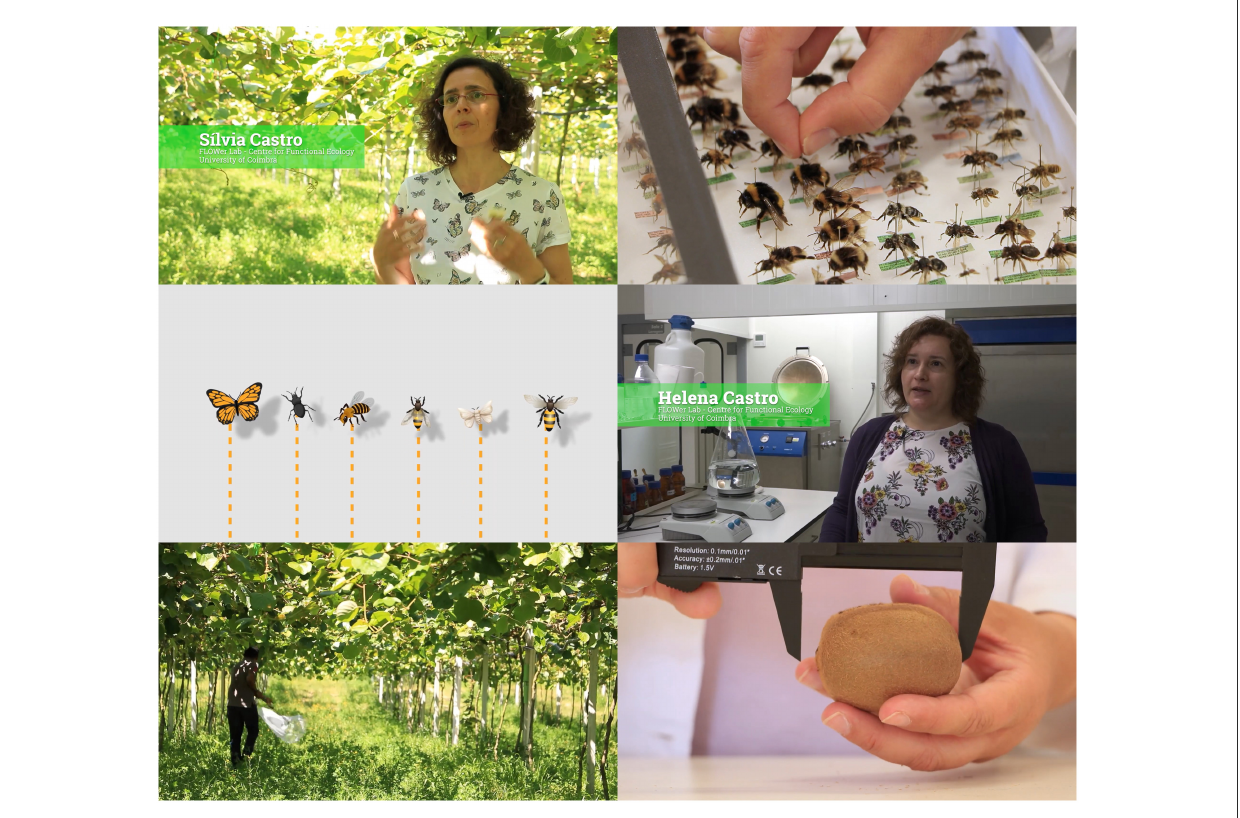
FIGURE1 Screenshots from the final version of the video